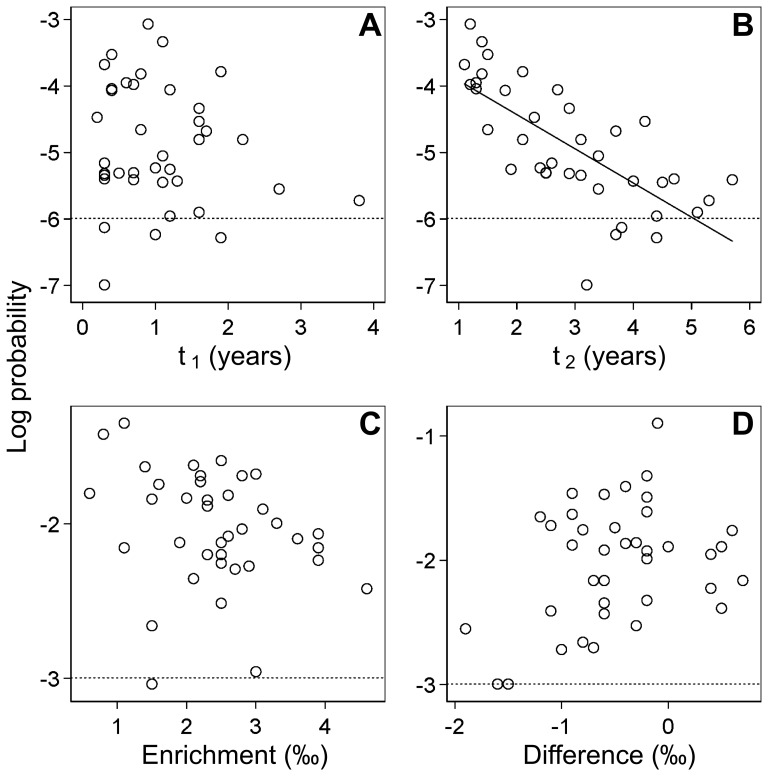
Relationships between MDEs and the logarithms of the probabilities of the four weaning parameters for the archaeological populations.Dotted lines indicate the thresholds of probability. (A) and (B) The age at the start and end of weaning, respectively. (C) -enrichment from maternal to infant tissue. (D) The difference between the  value of collagen synthesized entirely from weaning foods and the mean  value for all adults. A regression line is also shown for  (slope = −0.514, intercept = −3.403).